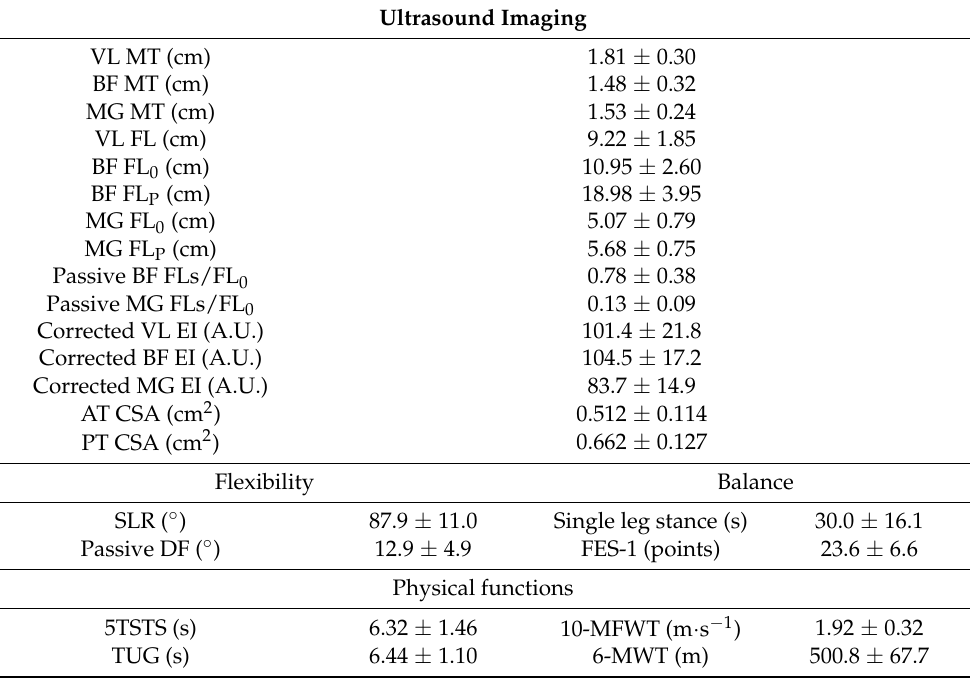
Table 2. Means ( ± SD) for musculotendinous ultrasound imaging, flexibility, balance, and functional movement tests of the study participants ( n =